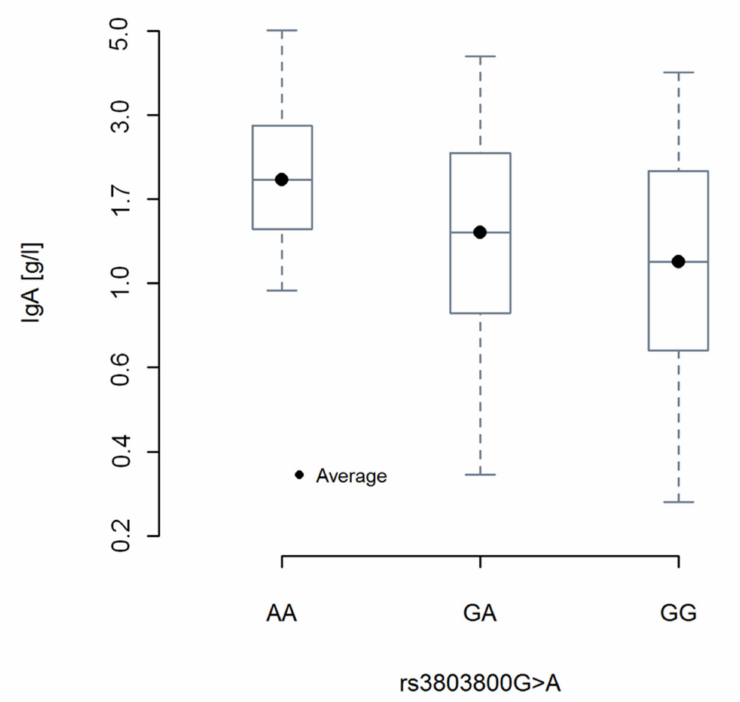
Figure 1. Levels of plasma IgA (g / L) in groups of patients according to the rs3803800G > A genotype. Box-and-whisker plots in standard manner with expected value as central points, 1st and 3rd quartiles and min-max values. The average levels of IgA (g / L) in groups of patients according to rs3803800G > A genotype AA, GA, and GG are 1.89, 1.36, and 1.14, respectively. Pearson’s correlation coe ffi cient between these averages and genotypes is r altering = –0.987. It means that there is a strong linear relationship between rs3803800G > A genotype and expected value of IgA, but this coe ffi cient ignores variability of IgA (g / L) within groups with a particular genotype. When this additional within-group variation is incorporated, the e ff ect size correlation between genotype and IgA is r e ff ect size = –0.140. Observed di ff erences between average levels of IgA in three groups are significant with F = 4.2475; p =